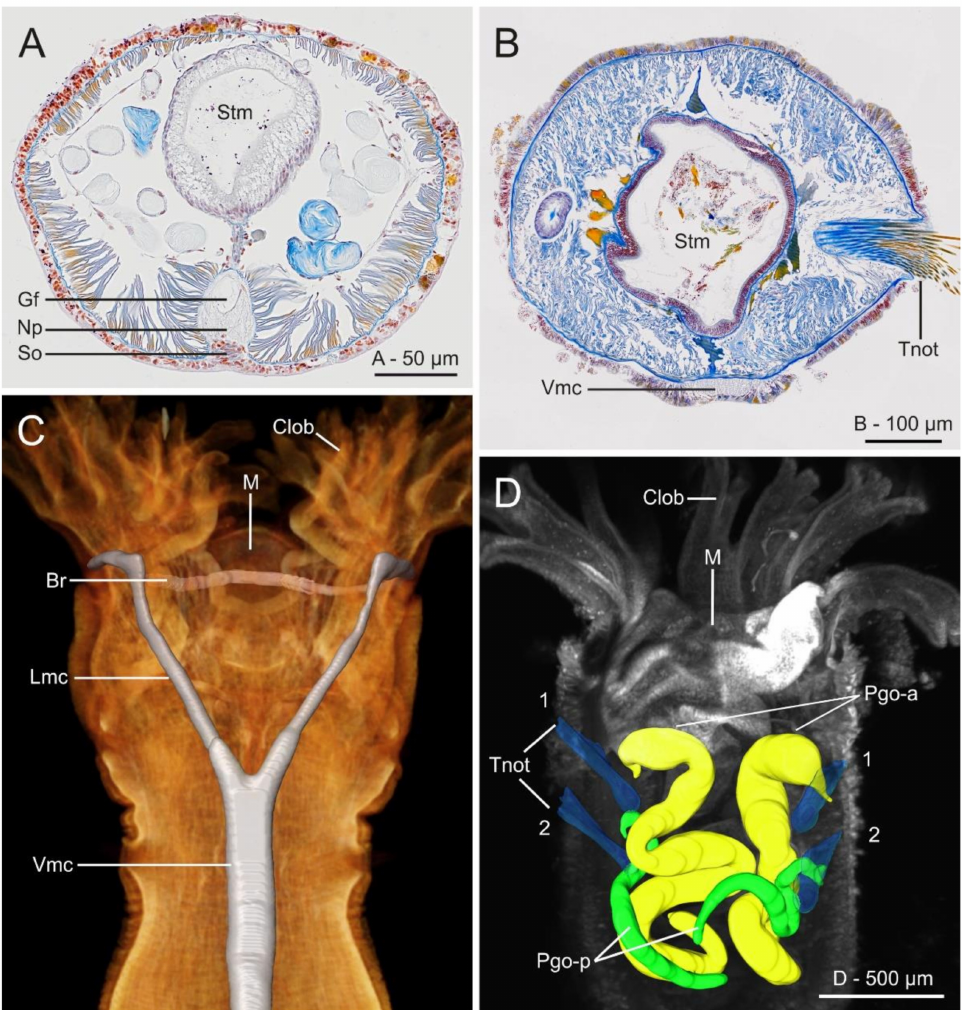
Figure 21. Histological cross sections (azan staining) at gut level of ( A ) Myriowenia sp. and ( B ) Owenia fusiformis ; ( C ) micro- computed tomography ( µ CT) volume rendering and 3D-reconstruction of the nervous system of O. fusiformis ; ( D ) 3D reconstruction of parapodial glandular organs (Pgo); anterior pair are in yellow, posterior ones are in green; notochaetae in blue. ( A–C ) From Beckers et al. [161]; ( D ) from Rimskaya-Korsakova et al. [148]. All modified from the